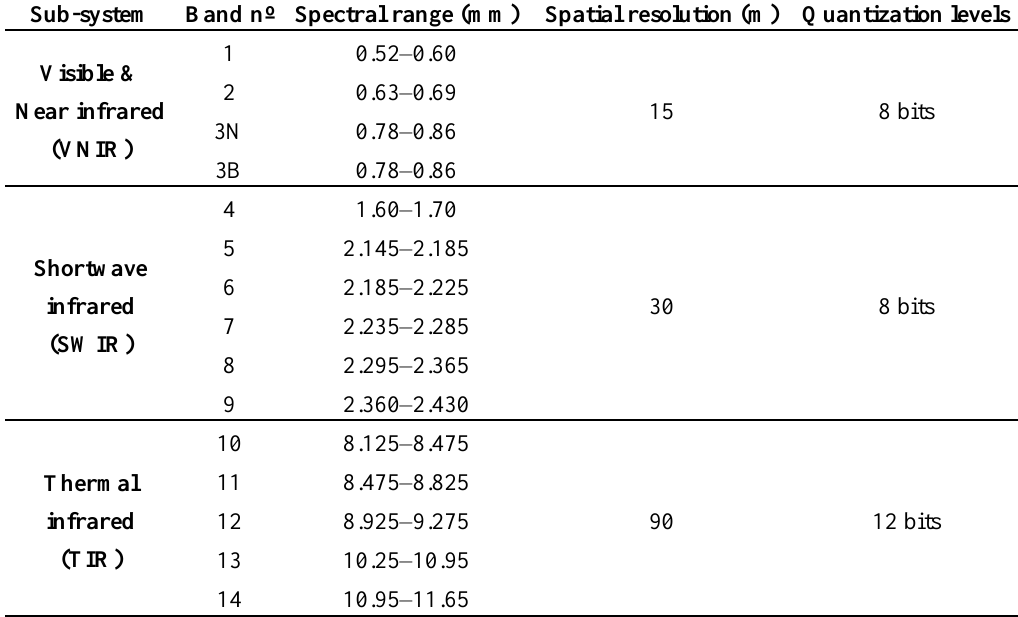
Table 1. Main characteristics of the ASTER sensor systems.